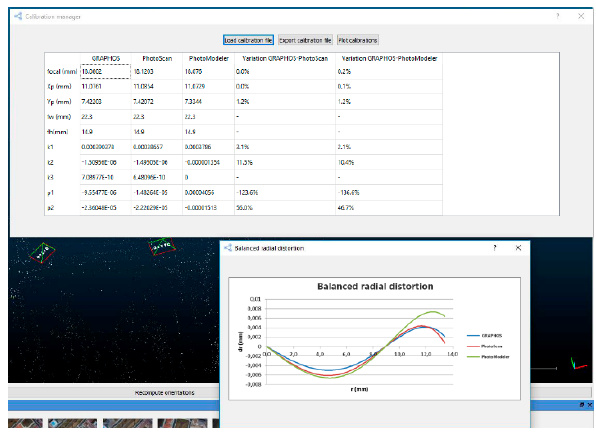
Figure 8. Calibration manager and radial distortion profiles tools.